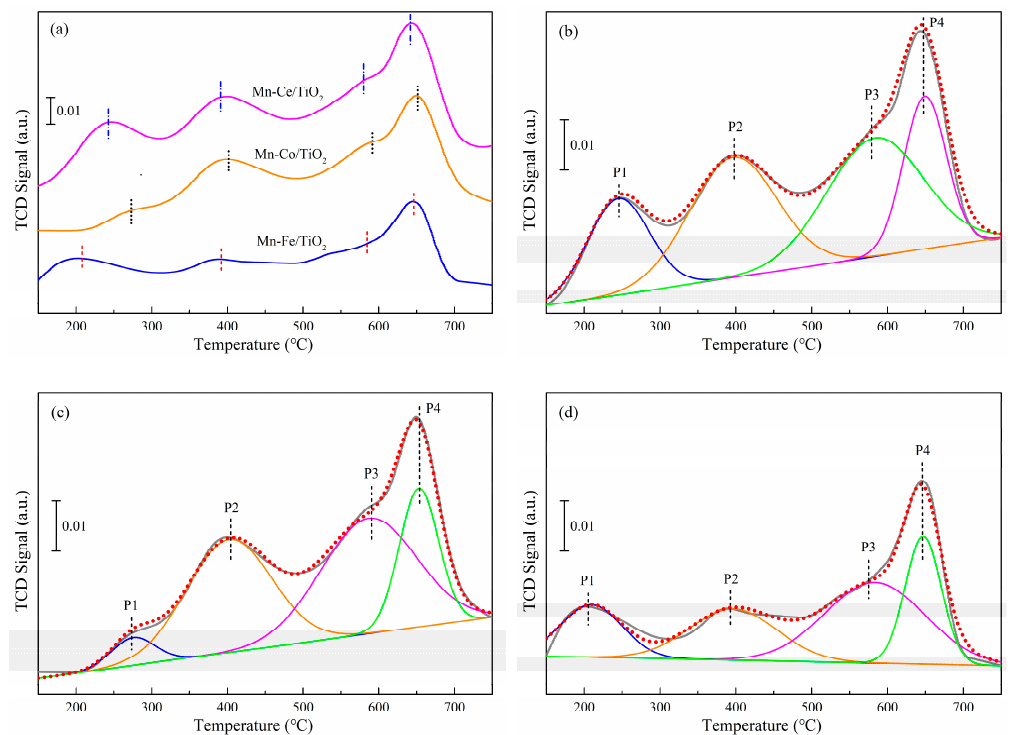
Figure 7. NH 3 -TPD profiles of Mn-based bimetallic nanocatalysts: ( a ) Total NH 3 -TPD curves; ( b ) multi-peaks Gaussian fitting for Mn − Ce/TiO 2 nanocatalyst; ( c ) multi-peaks Gaussian fitting for Mn − Co/TiO 2 nanocatalyst; ( d ) multi-peaks Gaussian fitting for Mn − Fe/TiO 2 nanocatalyst. 429 Table 4. Quantitative analysis of NH 3 -TPD profiles. 430